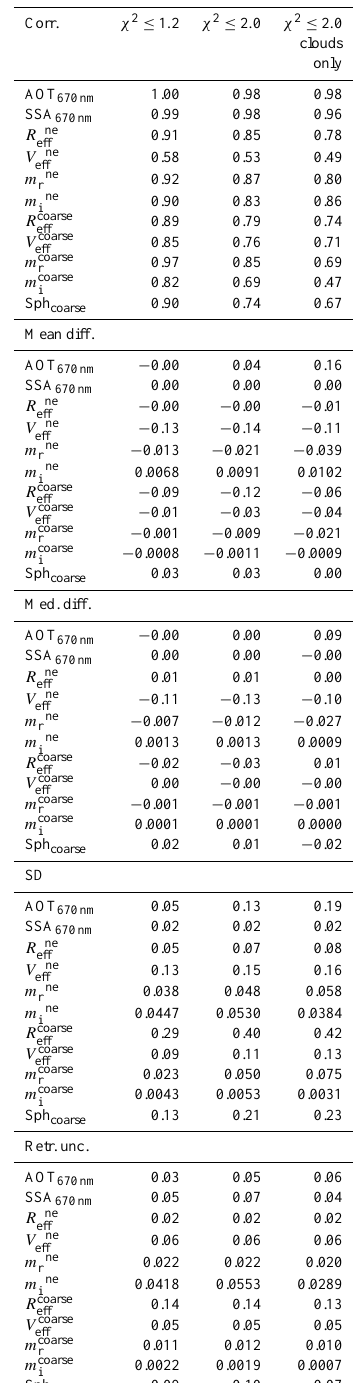
Table 3. The correlations, mean and median differences, SDs and retrieval uncertainties are given for the retrieved and derived param- eters in three data sets: (i) all retrievals with χ 2 ≤ 1 . 2, (ii) all re- trievals with χ 2 ≤ 2 . 0 and (iii) only the retrievals in clouded scenes with χ 2 ≤ 2 . 0. The units for size parameters R eff and V eff are in